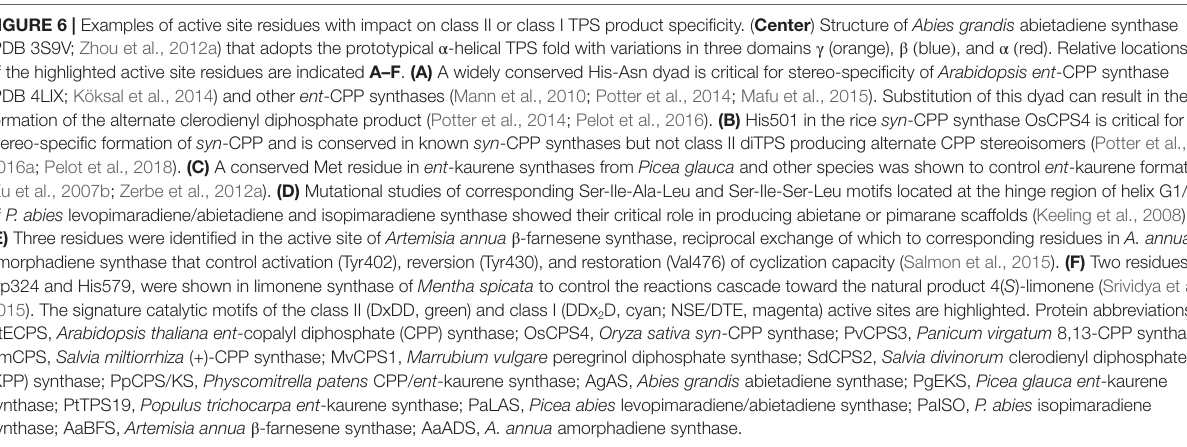
FIGURE 6 | Examples of active site residues with impact on class II or class I TPS product specificity. ( Center ) Structure of Abies grandis abietadiene synthase (PDB 3S9V; Zhou et al., 2012a) that adopts the prototypical α -helical TPS fold with variations in three domains γ (orange), β ( blue ) , and α ( red). Relative locations of the highlighted active site residues are indicated A–F . (A) A widely conserved His-Asn dyad is critical for stereo-specificity of Arabidopsis ent -CPP synthase (PDB 4LIX; Köksal et al., 2014) and other ent -CPP synthases (Mann et al., 2010; Potter et al., 2014; Mafu et al., 2015). Substitution of this dyad can result in the formation of the alternate clerodienyl diphosphate product (Potter et al., 2014; Pelot et al., 2016). (B) His501 in the rice syn -CPP synthase OsCPS4 is critical for the stereo-specific formation of syn -CPP and is conserved in known syn -CPP synthases but not class II diTPS producing alternate CPP stereoisomers (Potter et al., 2016a; Pelot et al., 2018). (C) A conserved Met residue in ent -kaurene synthases from Picea glauca and other species was shown to control ent -kaurene formation (Xu et al., 2007b; Zerbe et al., 2012a). (D) Mutational studies of corresponding Ser-Ile-Ala-Leu and Ser-Ile-Ser-Leu motifs located at the hinge region of helix G1/2 of P. abies levopimaradiene/abietadiene and isopimaradiene synthase showed their critical role in producing abietane or pimarane scaffolds (Keeling et al., 2008). (E) Three residues were identified in the active site of Artemisia annua β -farnesene synthase, reciprocal exchange of which to corresponding residues in A. annua amorphadiene synthase that control activation (Tyr402), reversion (Tyr430), and restoration (Val476) of cyclization capacity (Salmon et al., 2015). (F) Two residues, Trp324 and His579, were shown in limonene synthase of Mentha spicata to control the reactions cascade toward the natural product 4( S )-limonene (Srividya et al., 2015). The signature catalytic motifs of the class II (DxDD, green) and class I (DDx 2 D, cyan; NSE/DTE, magenta) active sites are highlighted. Protein abbreviations: AtECPS, Arabidopsis thaliana ent -copalyl diphosphate (CPP) synthase; OsCPS4, Oryza sativa syn -CPP synthase; PvCPS3, Panicum virgatum 8,13-CPP